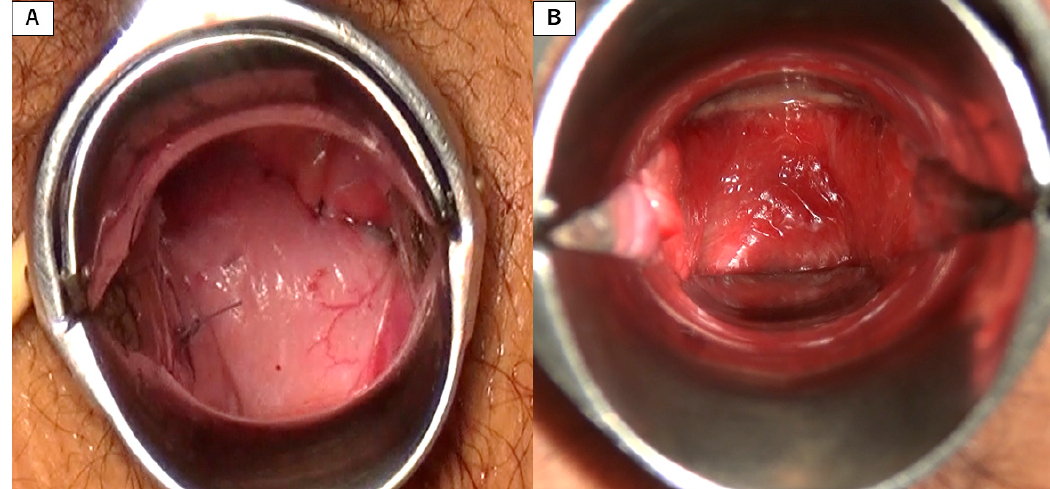
Figure 4. Speculum exam of the apex of the neovagina. ( A ) The neovaginal apex created by suturing the supravesical and suprarectal peritoneum is shown immediately postoperatively. ( B ) The mucosa of the neovagina is epithelialized without granulation tissue formation three months postoperatively.